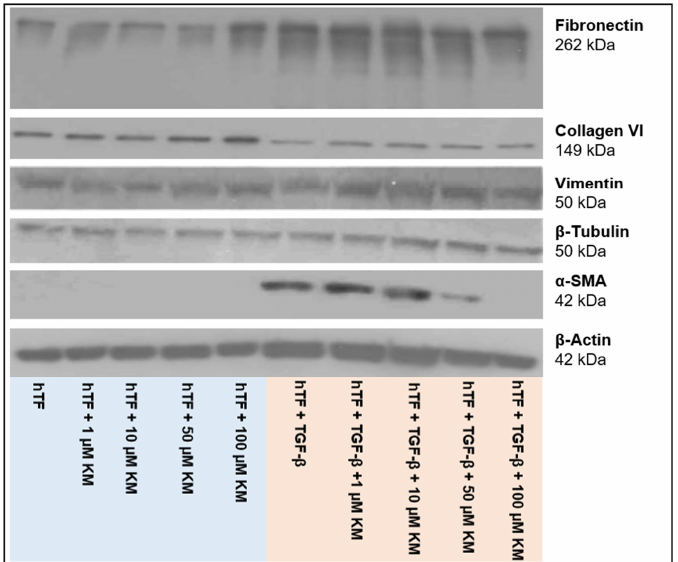
Figure 3. Western blot analysis for in vitro evaluation of the antifibrotic effect of kitasamycin (KM) in a TGF- β 1-mediated fibrotic cell culture model. Western blot analysis of human Tenon’s fibroblast (hTF) cell lysates under different culture conditions. Cells were treated with increasing concentrations of KM (hTFs + 1–100 µ M KM) alone, TGF- β 1 alone (hTFs + TGF- β 1) and TGF- β 1 + KM (hTFs + TGF- β 1 + 1–100 µ M KM) for 48 h each. Cell lysates of untreated hTFs served as the controls. Antibodies against fibronectin (262 kDa), collagen VI (130 kDa), vimentin (58 kDa), β -tubulin (50 kDa), α -SMA (42 kDa) and β -actin (42 kDa) were used. The β -tubulin served as the loading control.